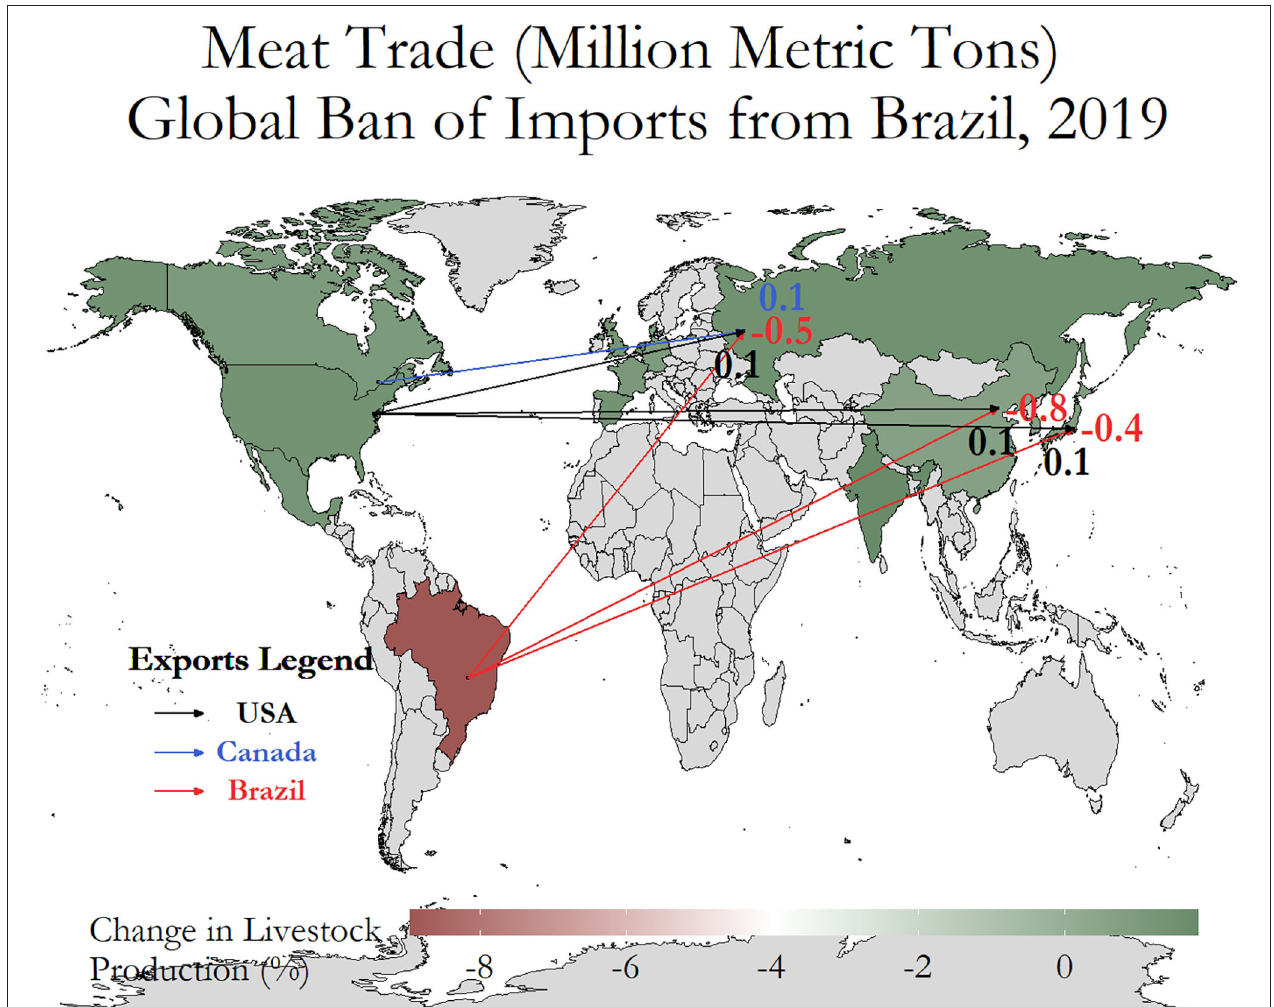
FIGURE 5 | Change in meat exports in million metric tons (MMT). The ban decreases Brazil’s production by 8.5% in 2019. The U.S. assumes the role of leading exporter, by increasing its exports to all trade partners, including China, Europe, and